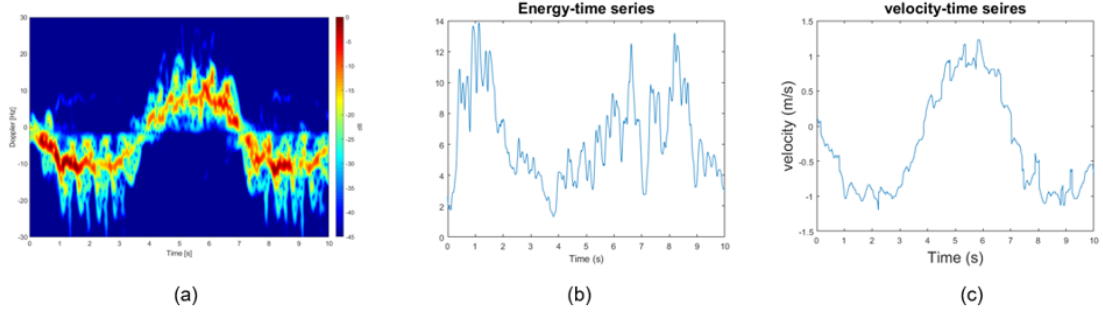
Figure 4. ( a ) micro-Doppler spectrogram and ( b ) extracted TSFRESH input energy-time series, ( c ) velocity-time